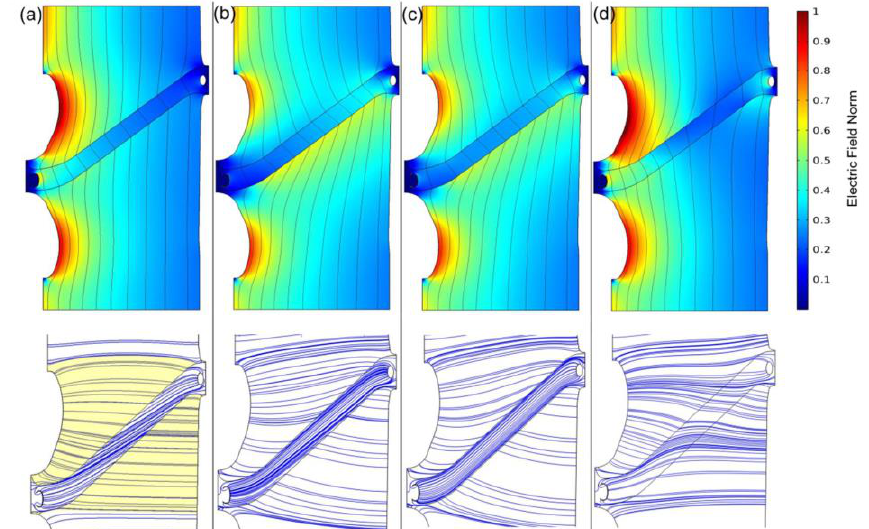
Figure 3. Electric field for conical insulator. Top: Field distribution and equipotential lines for a conical insulator; Bottom: Field lines (yellow filled area: ion capture volume) at 330 kV for ( a ) capacitive, ( b ) DC, 10 − 21 S / m residual gas conductivity, 0 IP / (cm 3 · s), ( c ) DC, 29 IP / (cm 3 · s) (ions from natural ionization), ( d ) DC, 290 IP / (cm 3 · s) (10 × natural ionization). 20 ◦ K temperature gradient on insulator surface [34].